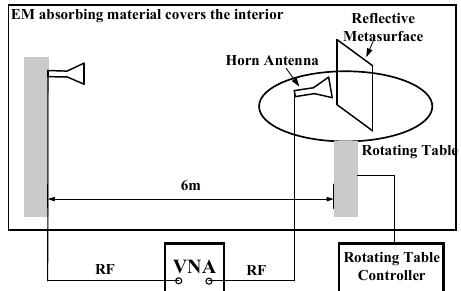
Figure 8. The far field measurement settings. The far-field patterns were measured, processed and shown in Figure 9 in black lines. For brevity, we only show the far-field of the reflected RHCP vortex beam at 4 GHz, 6 GHz and 8 GHz. The corresponding simulated results is also shown in Figure 8 in red lines for comparison. The simulated results and measurement results agree well with each other. It can be seen from Figure 9 that the vortex beams show clear amplitude nulls at the propagating direction.